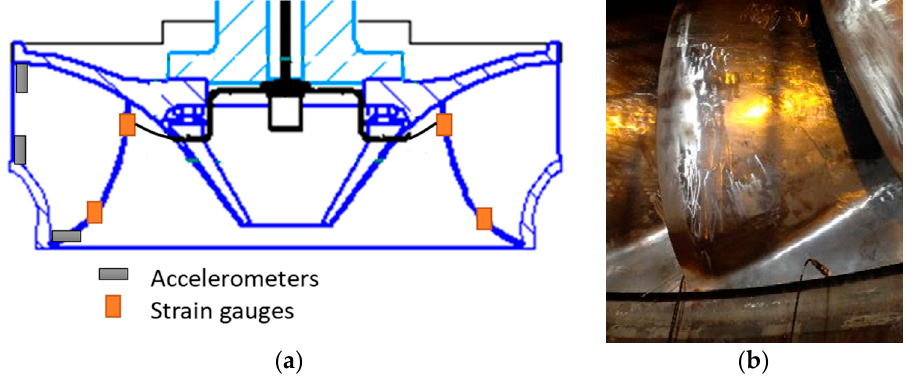
Figure 4. Detail of sensors available during the experimental modal analysis (EMA). ( a ) Sketch of the location of the accelerometers; ( b ) picture of the accelerometer located in the band outlet.